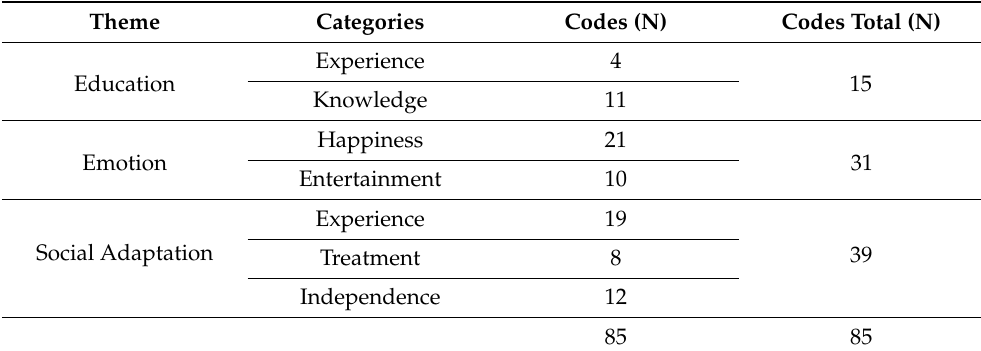
Table 8. Distribution of categories and codes for the metaphors that families produced about educa- tors about